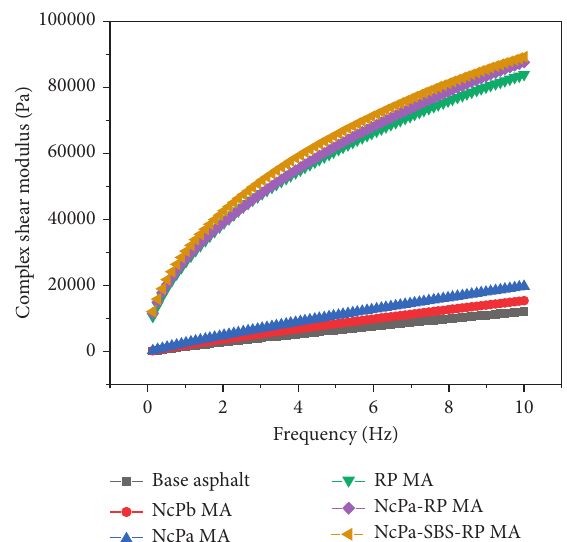
Figure 11: Loss factor versus